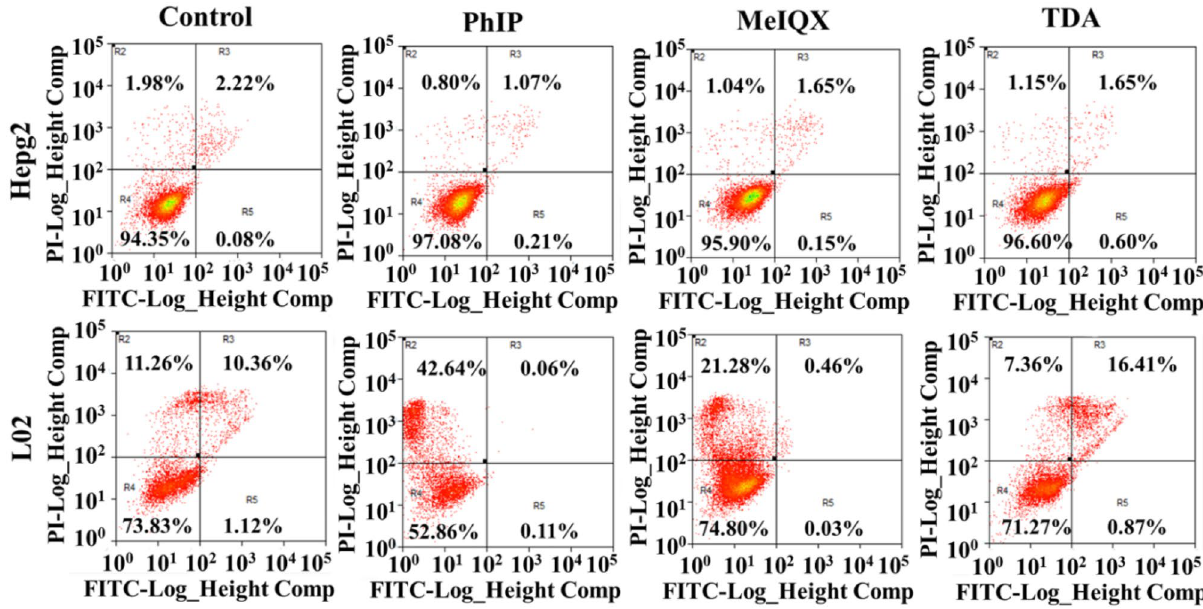
Figure 5. Flow cytometry of PhIP, MeIQx and TDA on HepG-2 and L02 cells after 4 μg/mL, 200 μL, incubation for 24 h. Regions R2, R3, R4 and R5 represent necrotic, late apoptotic, live and early apoptotic cells in the